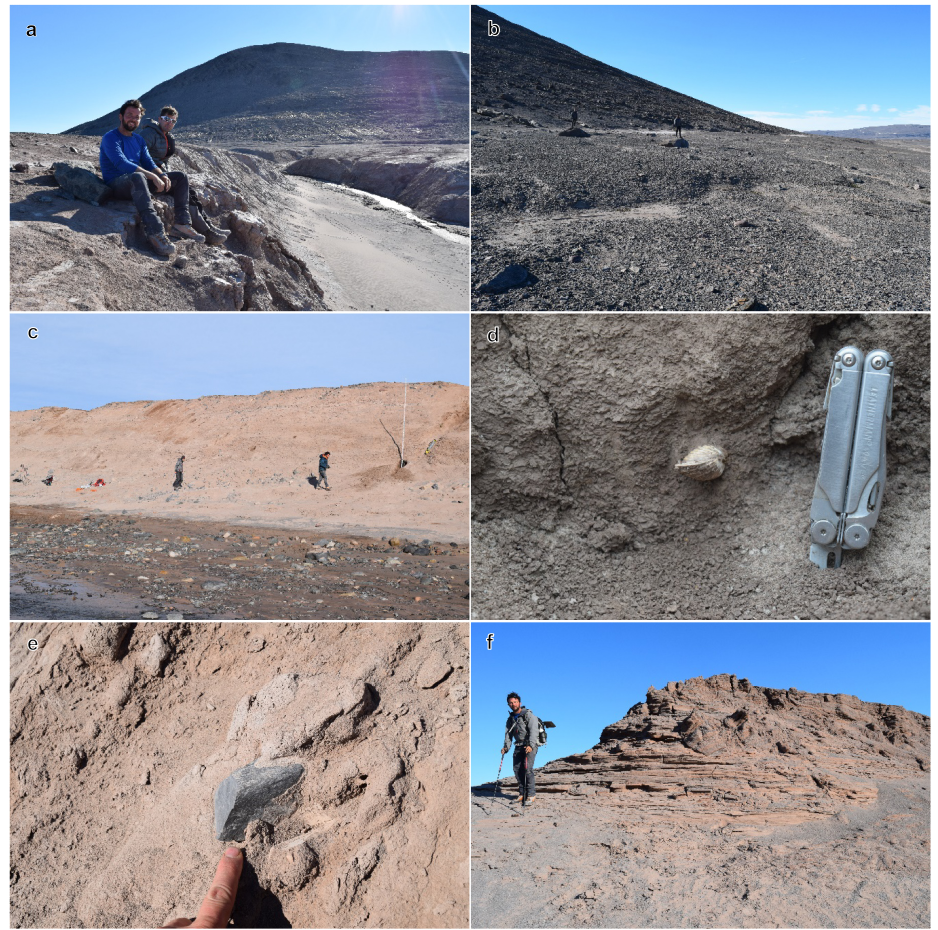
Figure 10. Photos of Blåsø uplifted glaciomarine (BUG) and deltaic sediments. Image (a) shows the uplifted glaciomarine sediments periph- eral to Blåsø at site EV1. The marine limit at ∼ 33ma . s . l . can be seen in the background. Below this, lithofacies BUG/LF1 is exposed due to local stream incision. Image (b) shows the marine limit at ∼ 33ma . s . l . close to site EV1. Image (c) shows lithofacies BUG/LF1 sediments exposed at site DIV 1. These are predominantly massive to partially stratified red clay/silts with an assemblage of paired molluscs. They are capped by a thin layer of gravel. Image (d) presents a paired Hiatella arctica valve within lithofacies BUG/LF1 at site DIV1. Image (e) shows a striated dropstone in lithofacies BUG/LF1, indicating an ice-rafted component within this lithofacies. Image (f) shows lithofacies BUG/LF2 exposed at site DIV2 at 28ma . s . l . This lithofacies varies in elevation but is characterised by planar and trough cross-bedded sand and gravels that often form distinctive flat surfaces peripheral to the Blåsø shoreline. Photographs were taken by David H.